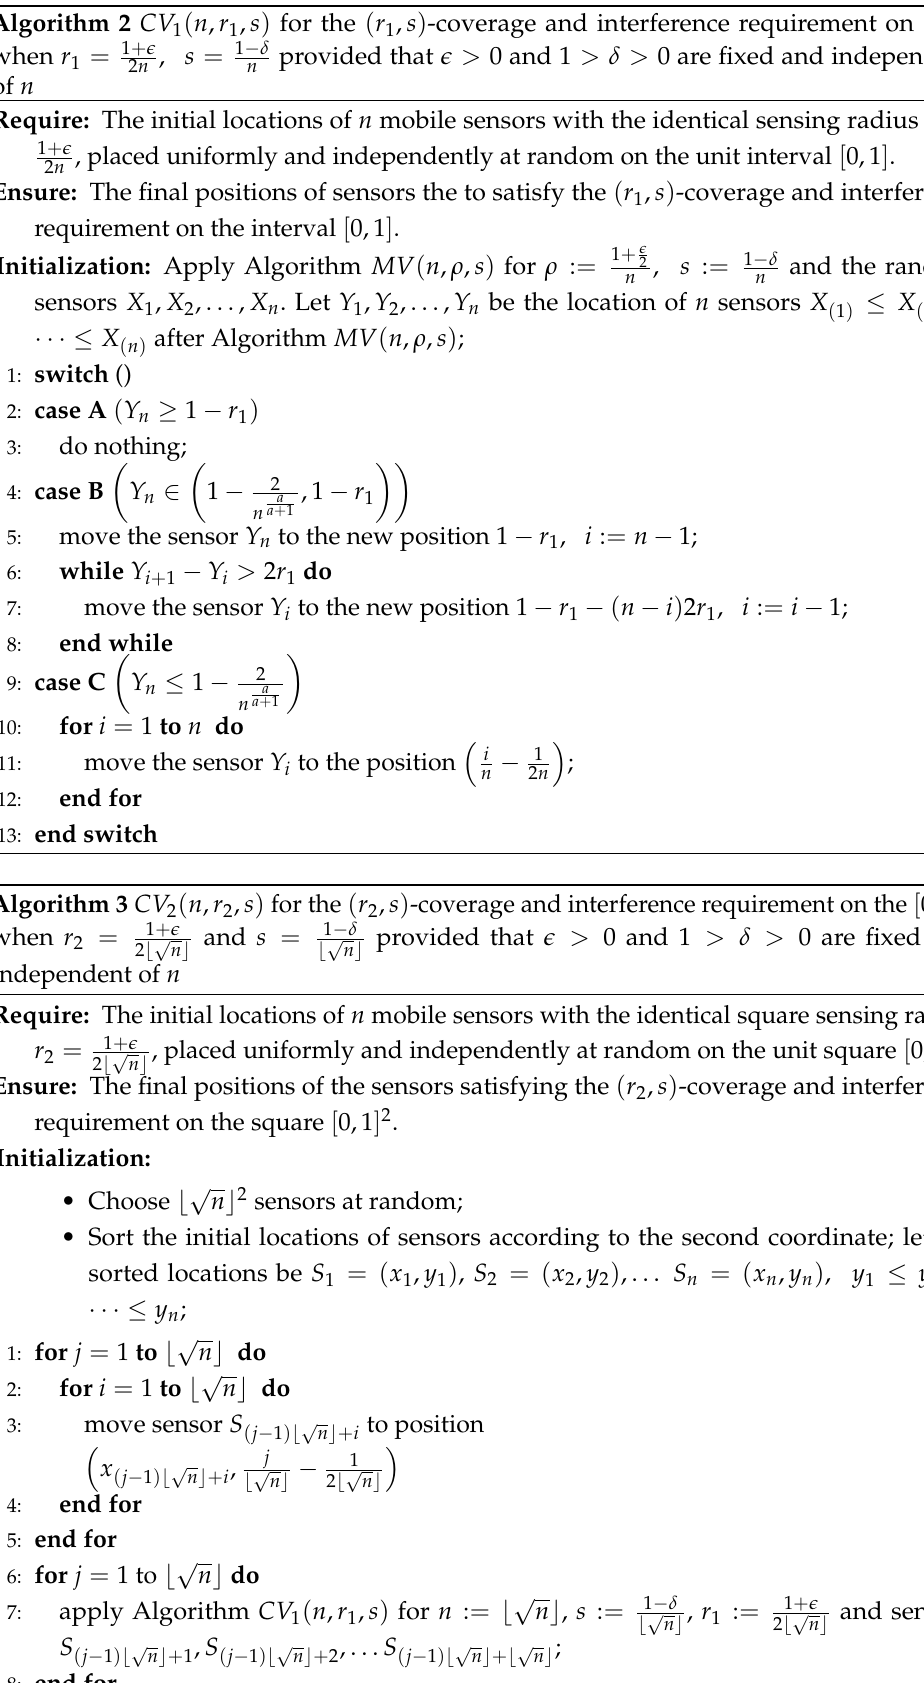
Algorithm 2 CV 1 ( n , r 1 , s ) for the ( r 1 , s ) -coverage and interference requirement on [ 0, 1 ]